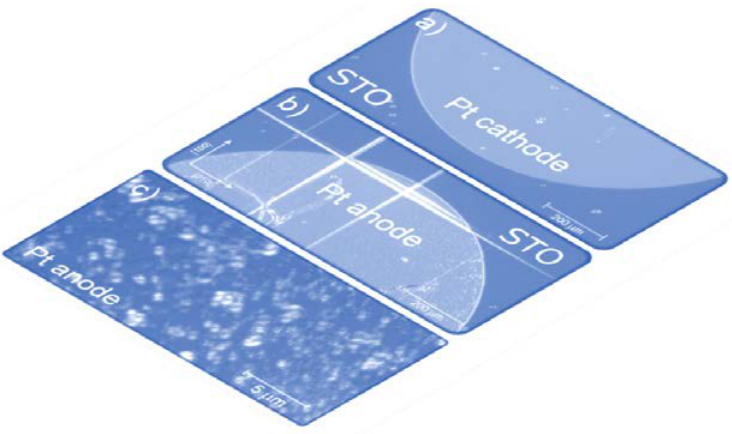
Figure 54. Images from the optical microscope (phase contrast) showing the sample after electrocoloration: ( a ) in the cathode region; ( b ) in the anode region; ( c ) magnification of the anode region with micro-bubbles. Adapted from [58].